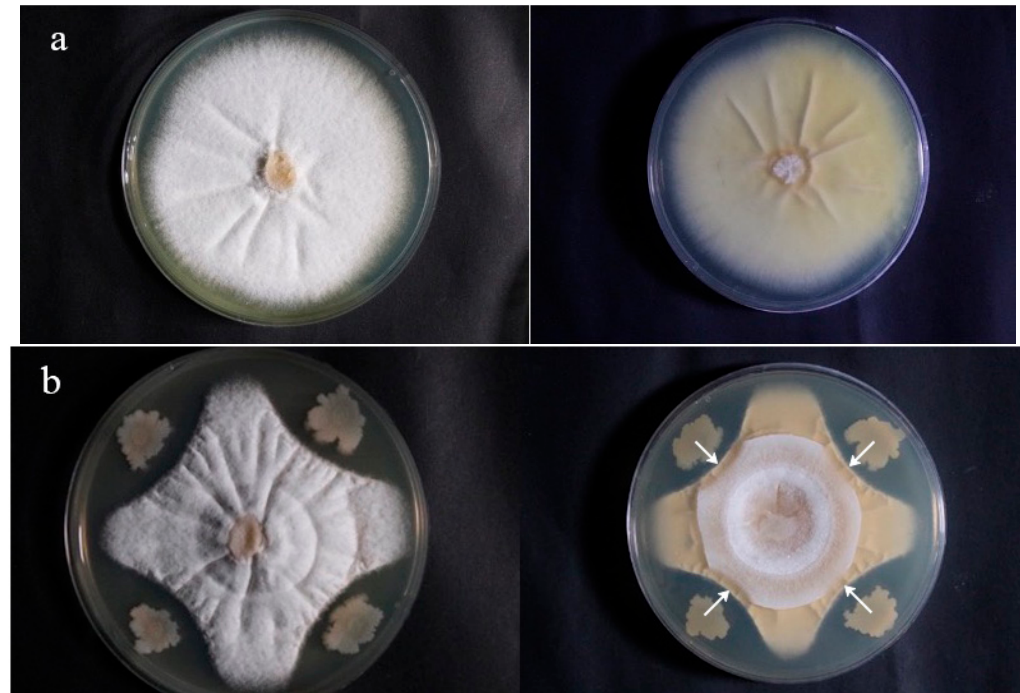
Figure 1. ( a ) The control group of Coriolus versicolor . ( b ) The inhibition zones produced by B72 strain against Coriolus versicolor .